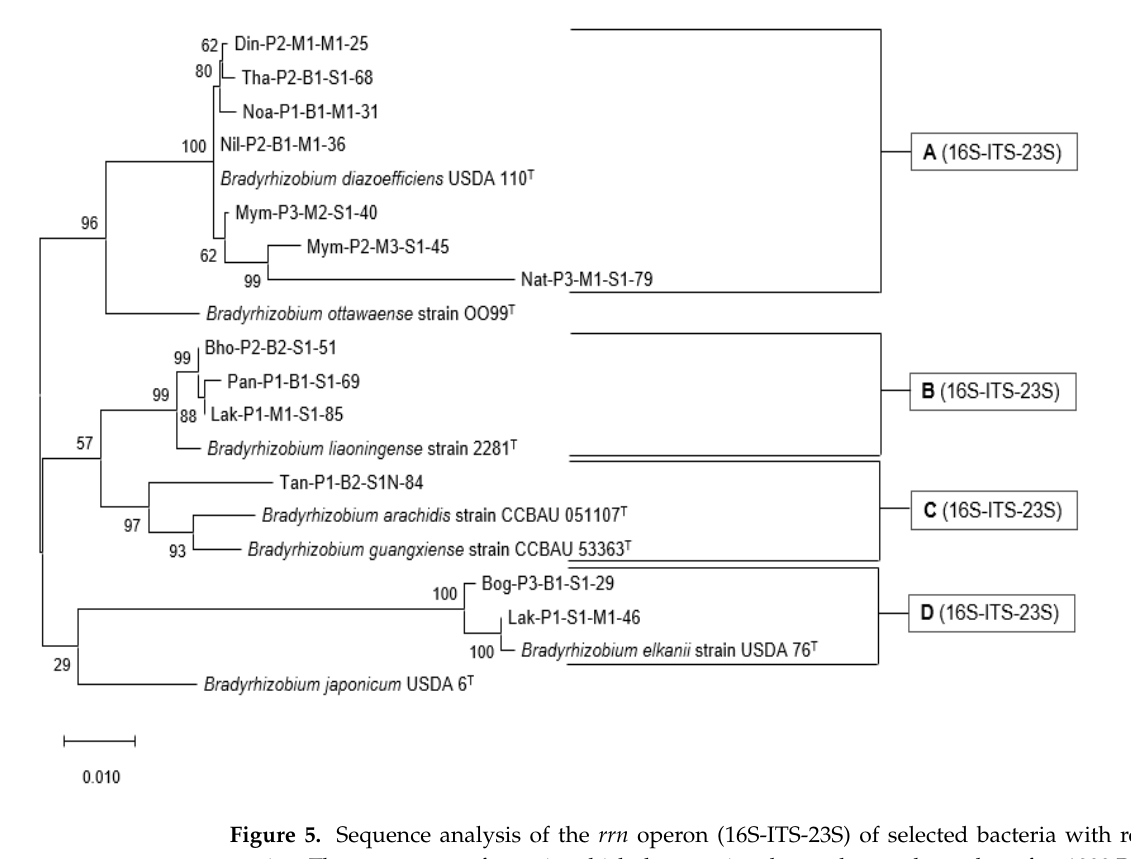
Figure 5. Sequence analysis of the rrn operon (16S-ITS-23S) of selected bacteria with reference strains. The percentage of trees in which the associated taxa clustered together after 1000 Bootstrap replications is shown next to the branch points.